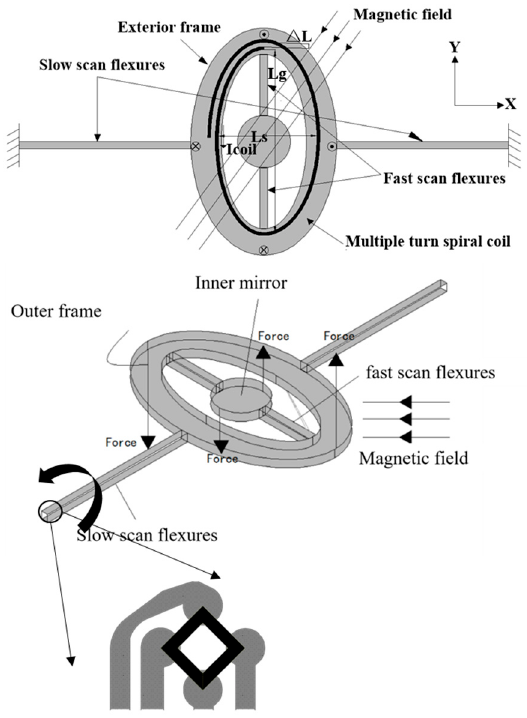
Figure 1. The basic structure of microeletromechanical systems (MEMS) micromirror with integrated piezoresistive sensor.